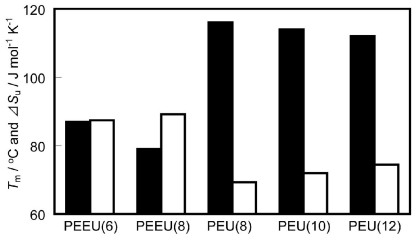
Thermal properties of PEEU(x) and PEU(y). Tm (■), ΔSu (□).